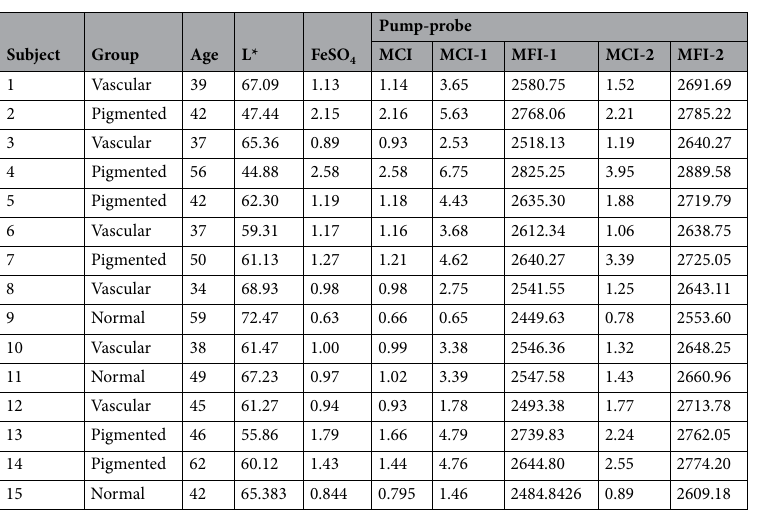
Table 1. Details and data of all subjects. MCI the melanin content index, MCI-1 MCI of the epidermal basal layer, MCI-2 MCI of the dermal layer, MFI-1 the mean fluorescence intensity of the epidermal basal layer, MFI- 2 the mean fluorescence intensity of the dermal